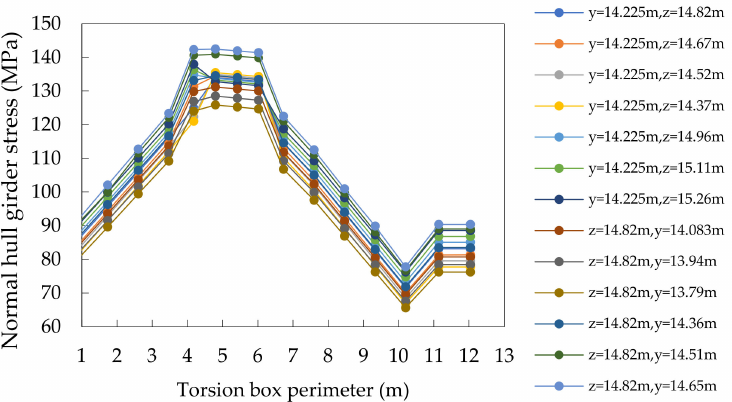
Figure 9. Evolution of normal hull girder stresses along the perimeter of the torsion box.